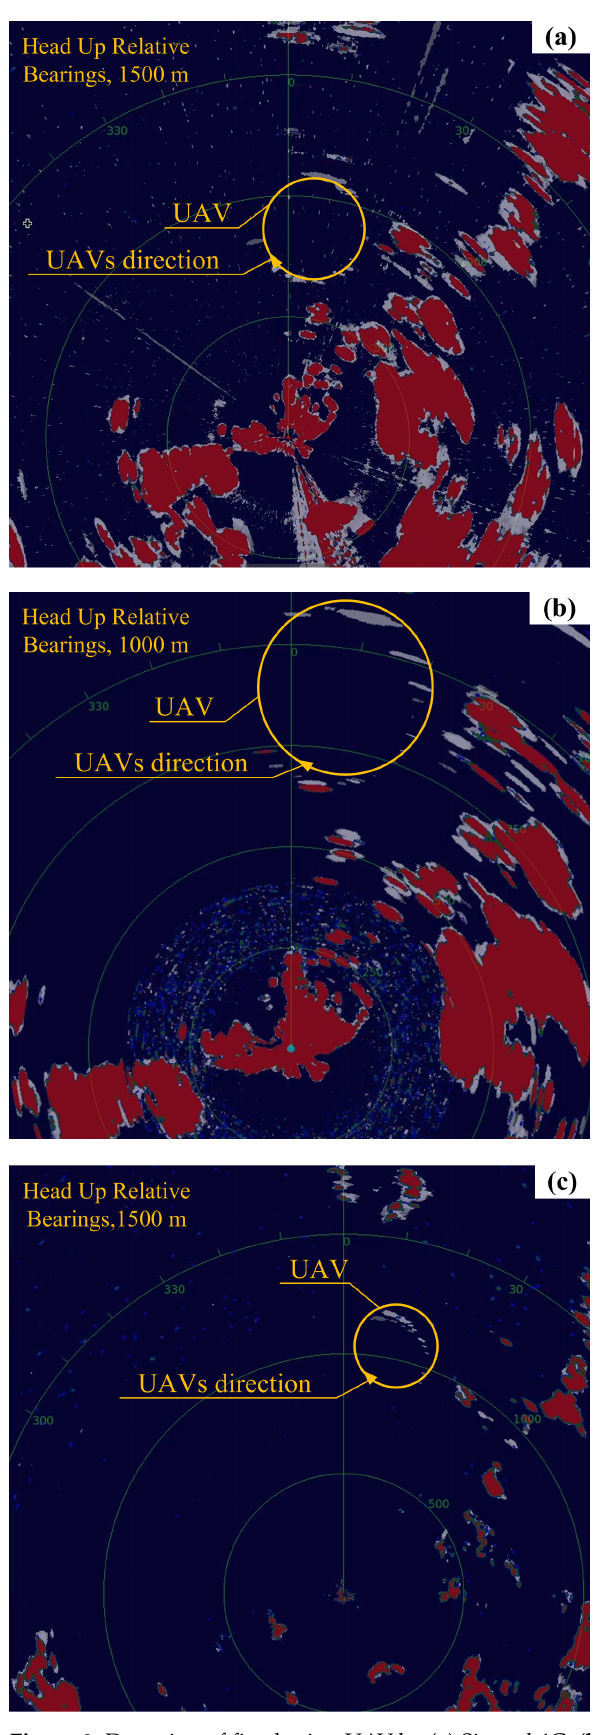
Figure 8. Detection of fixed-wing UAV by ( a ) Simrad 4G, ( b ) Halo20+, and ( c ) Halo3